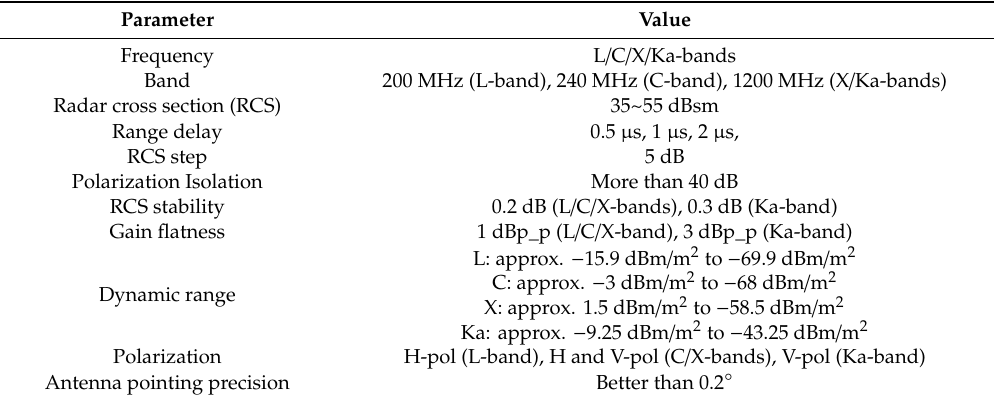
Table 1. Specifications of the multi-band ARC.